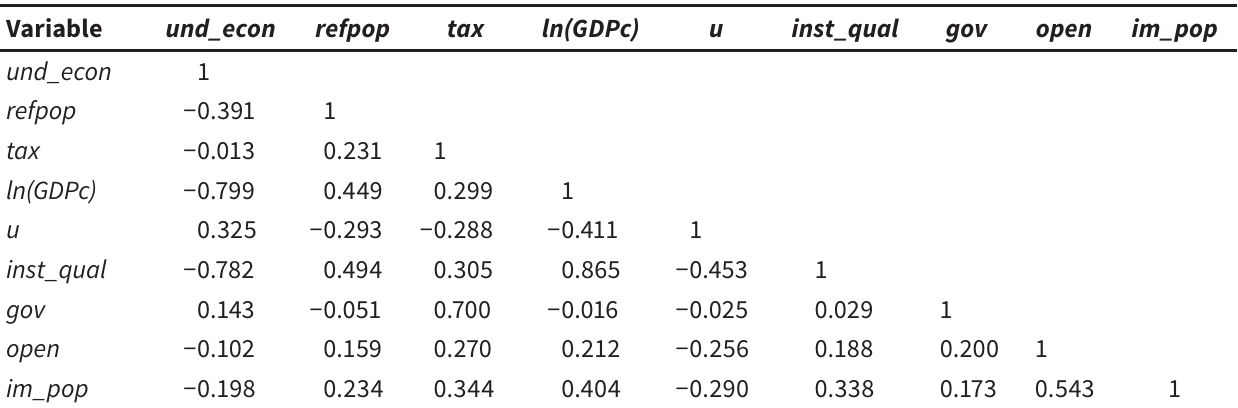
Matrix of correlation